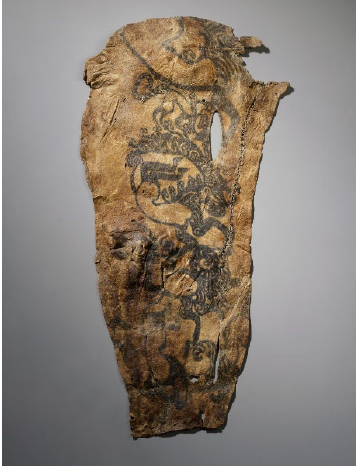
Figure 19. Tattoos on the right arm of a man (SHM inv. no. 1684 ‐ 298); mummified skin; Kurgan 2,